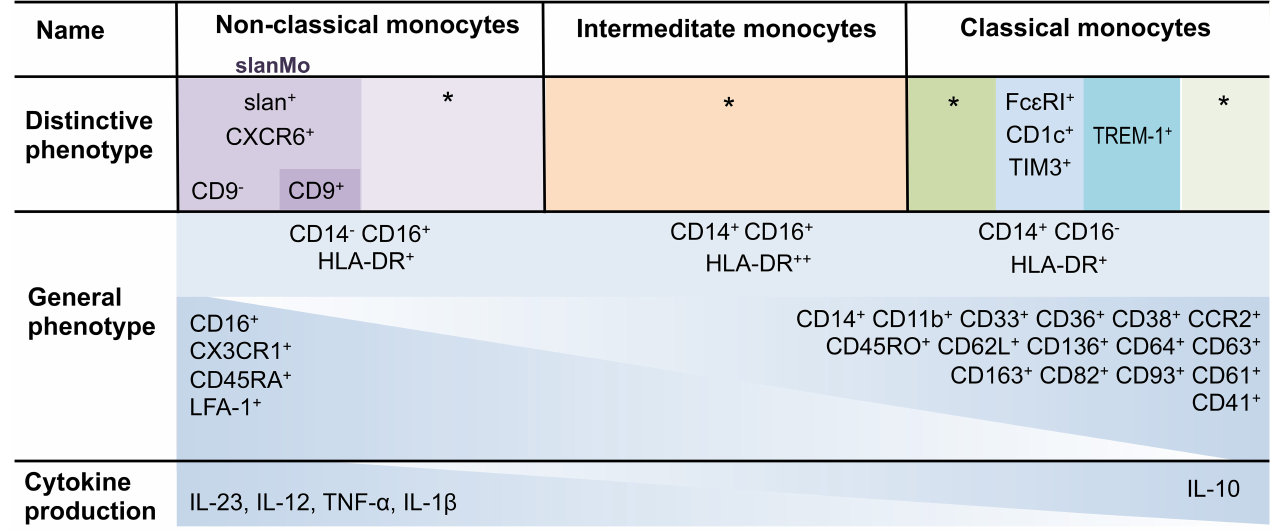
TABLE 1 | Human monocyte